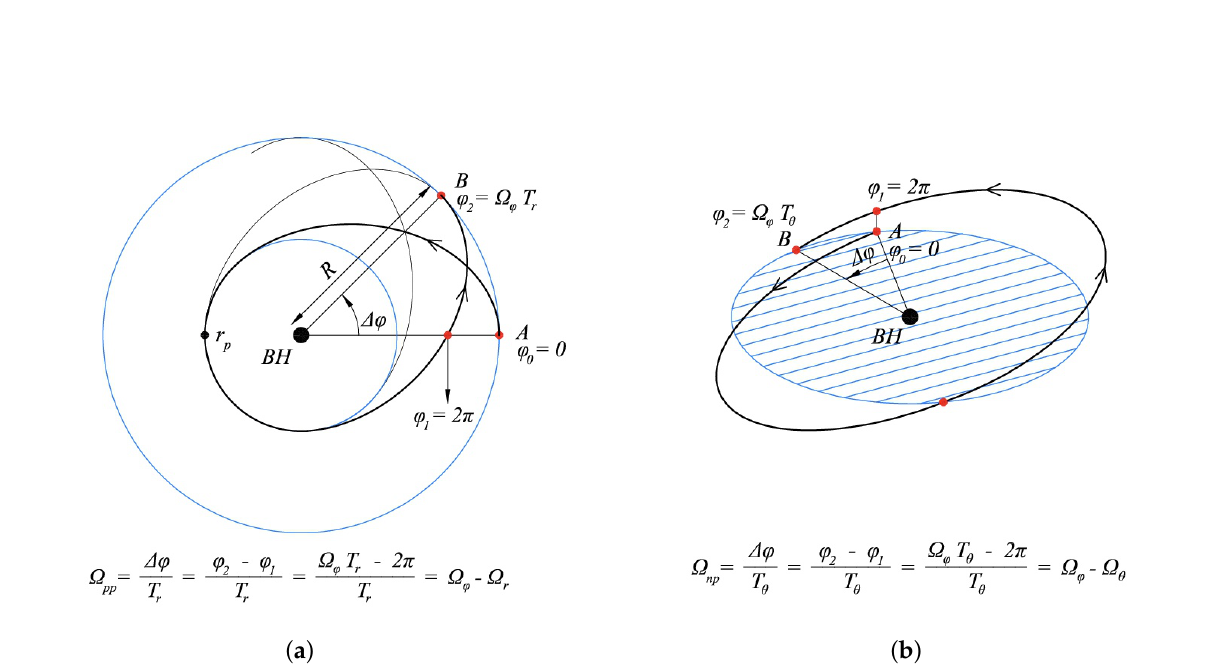
Figure 2. The figure represents the generalized relativistic precession phenomenon, near a Kerr black hole (BH) at the center rotating anti-clockwise, of the non-equatorial orbits ( Q (cid:54) = 0). Ω pp represents the periastron precession and Ω np represents the nodal precession frequency. The particle starts from the initial point A, and follows an eccentric and non-equatorial trajectory before completing one ( a ) radial, or ( b ) vertical oscillation to reach point B, where it sweeps an extra ∆ φ azimuthal angle during one ( a ) radial, or ( b ) vertical oscillation because the azimuthal motion is faster than the radial or vertical motion. Image courtesy: